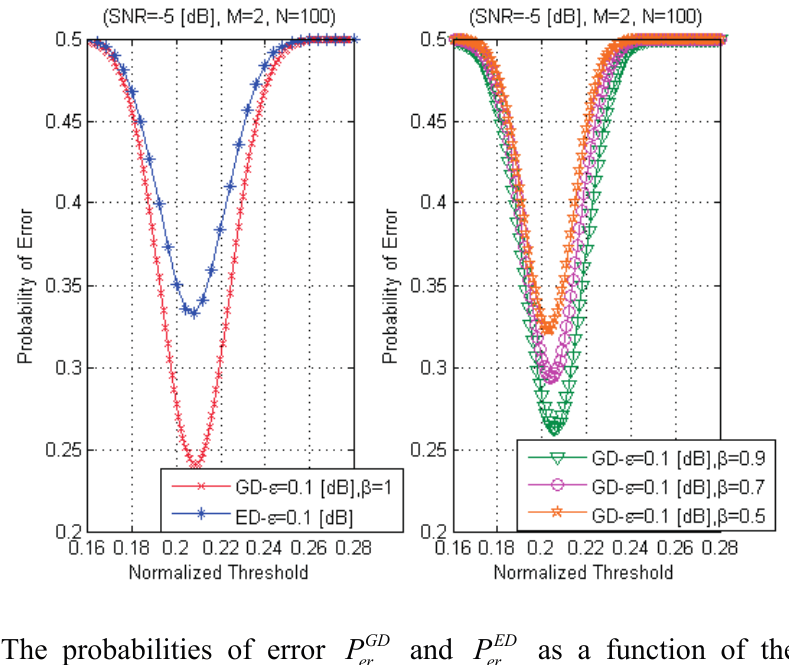
Figure 10. The probabilities of error GD σ ≠ σ threshold, 2 2 ξ η